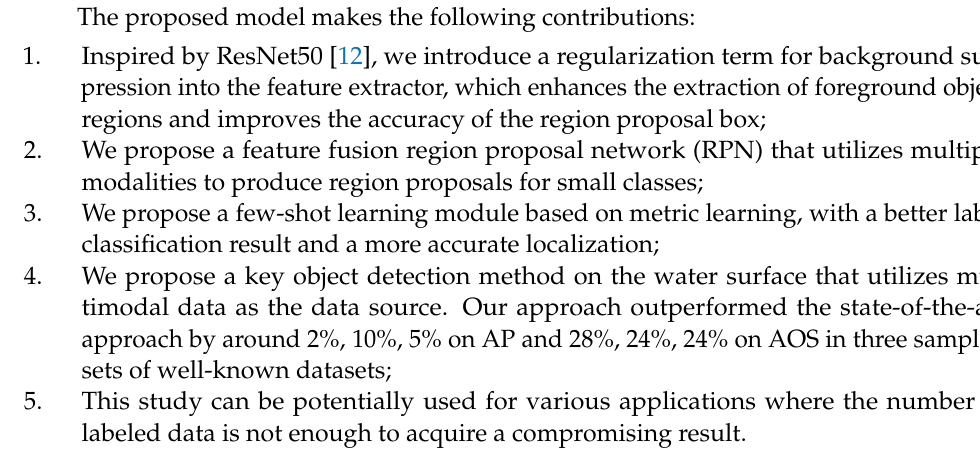
Figure 2. Prototype model of the few-shot object detection based on multimodal